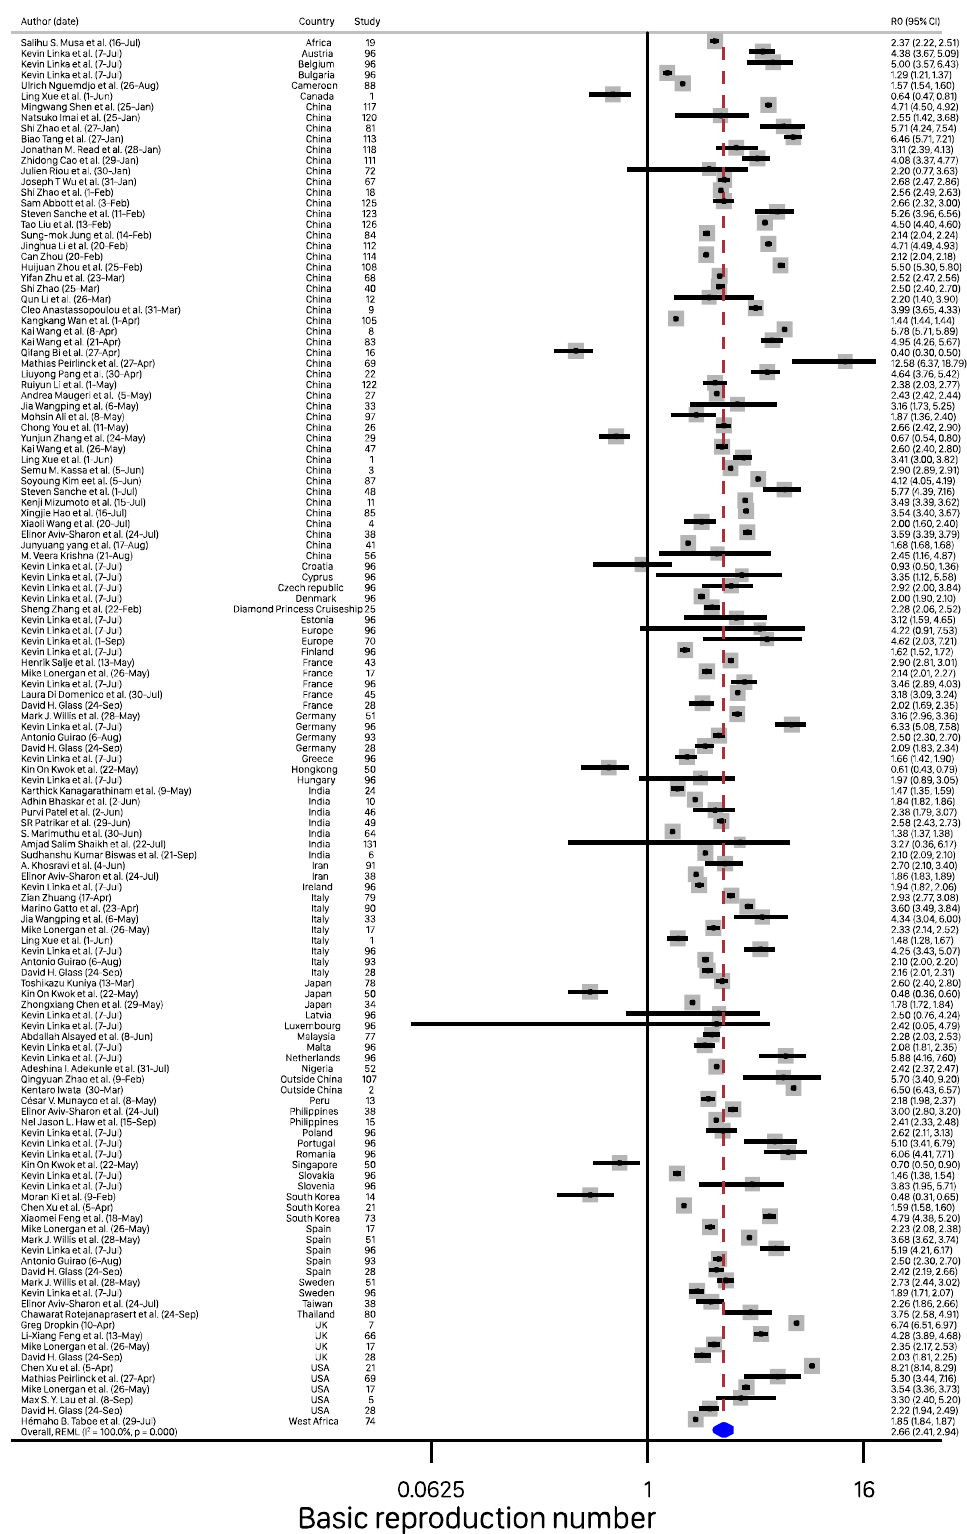
Figure 2. Pooled estimates of basic reproduction number values based on a random effects model.